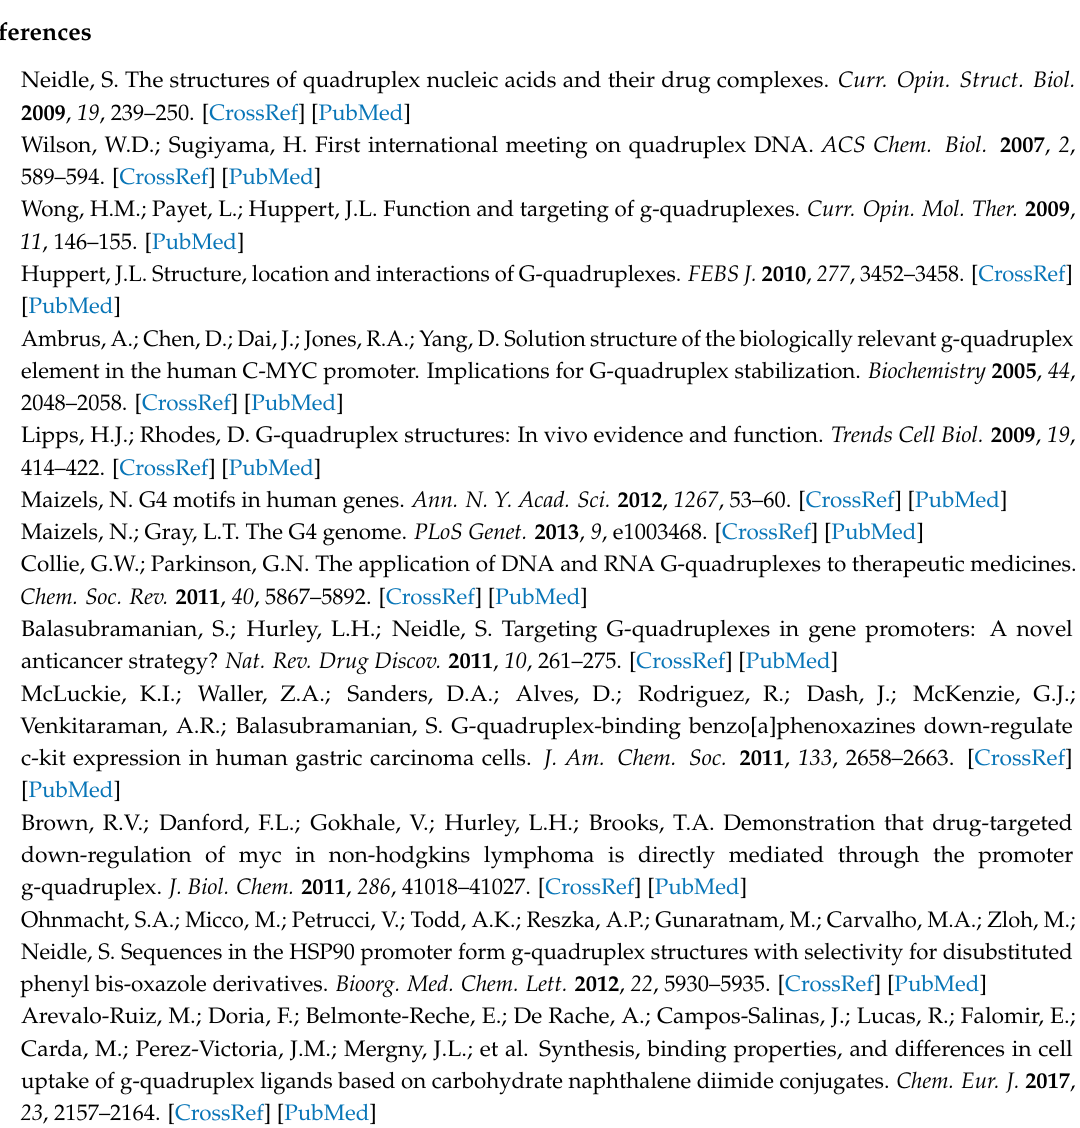
Supplementary Materials: The following are available online, LC-MS analysis, 1 H and 13 C NMR, Figure S1: G4-FID in the presence of ds26, Figure S2: Titration plots representing the change in ellipticity of 22AG in Na + -rich buffer at 292 nm and 260 nm with the addition of TOxAzaPy and